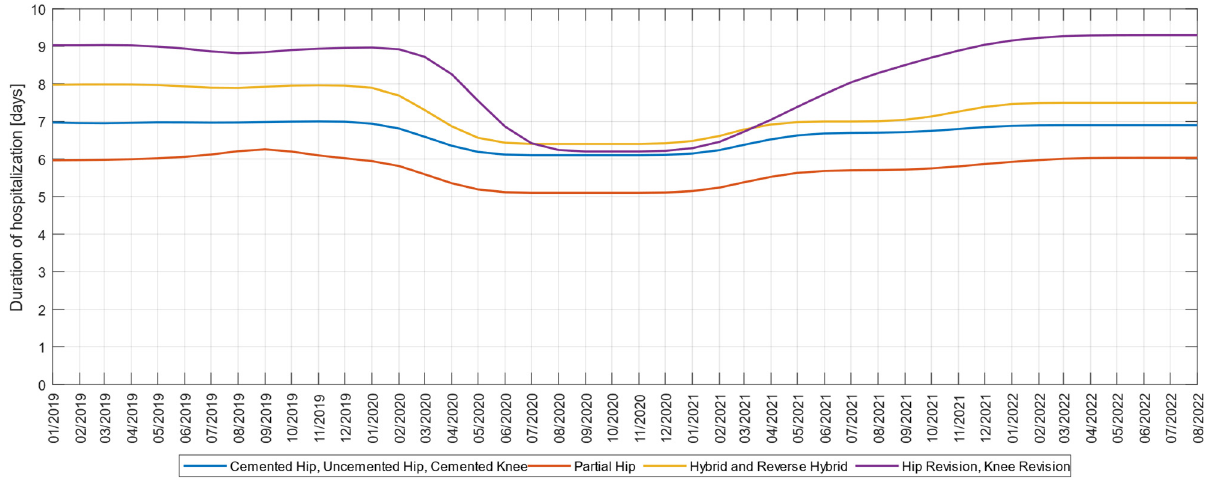
Figure 3. Three-month moving average of the monthly average length of hospital stays for: cemented hip-uncemented hip-cemented knee, partial hip, hybrid and reverse hybrid, revision knee-revision hip, for the interval 1st January 2019–1st September 2022.